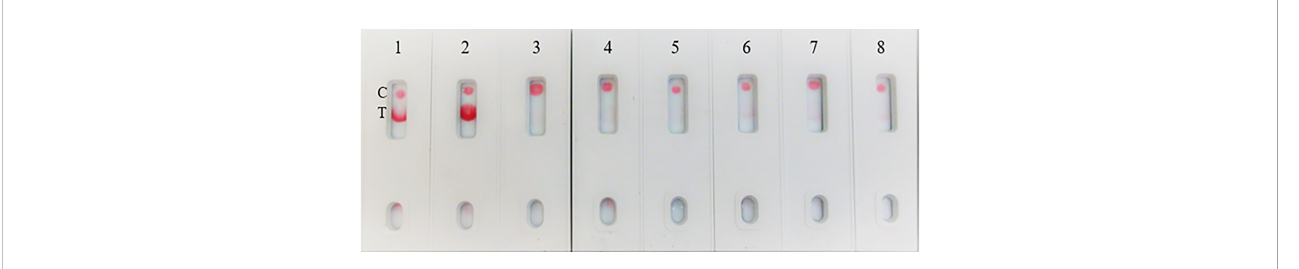
FIGURE 10 LFIA Cross-reactivity with Bacteria and Fungus Panel. 1. NR-52397 SARS-CoV-2 spike protein (positive control), 2. NR-52366 SARS-CoV-2 RBD protein (positive control), 3. NR-51849 Streptococcus pneumoniae SPEC1, 4. NR-46376 Staphylococcus epidermidis VCU013, 5. NR-51329 Pseudomonas aeruginosa EnvKY1, 6. NR-42457 Bordetella pertussis H921, 7. NR-29340 Candida albicans 23B, 8. Mucin (Sigma) (negative